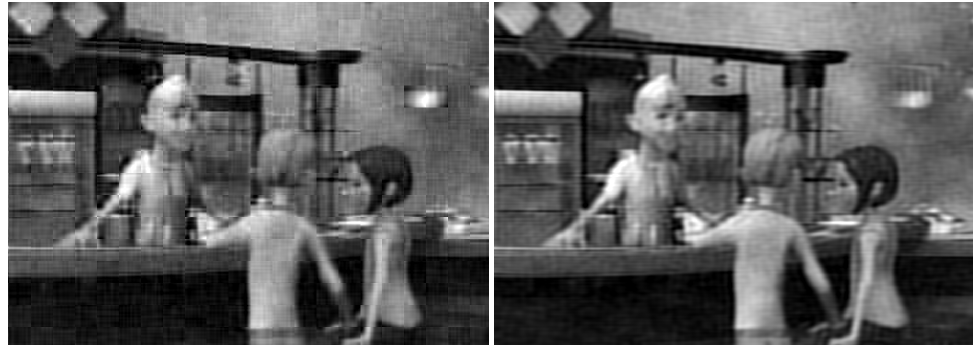
Figure 20. A detail from Figure 19. Left-hand side : JSCC-Cast with SSIM quality of 0.62. Right-hand side : Softcast with a SSIM quality of